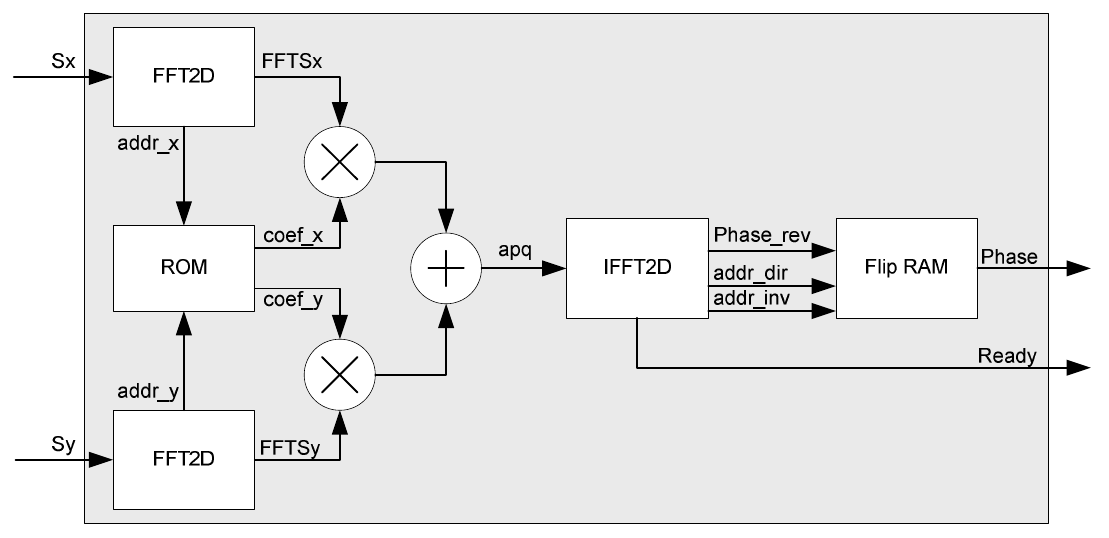
Figure 4. Architecture of the synthesized phase